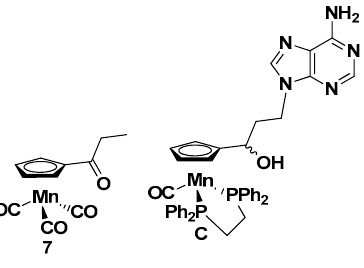
Figure 4. Structures of 7 and C .